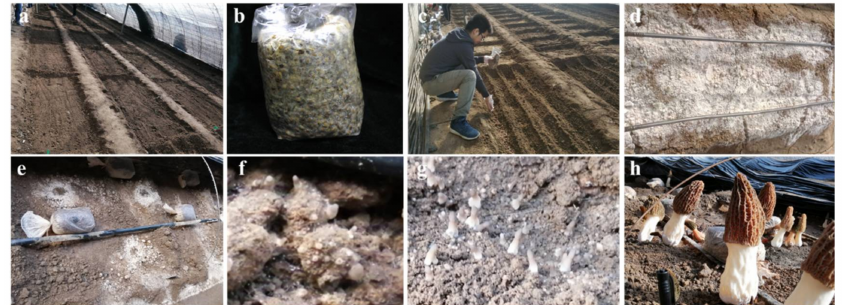
Figure 1. Fruiting body cultivation of morel. ( a ) Prepared soil; ( b ) spawn; ( c ) sowing the spawn; ( d ) conidia (‘powdery mildew’); ( e ) adding exogenous nutrition bags (ENB); ( f ) primordia; ( g ) delin- eating pileus and stipe; and ( h ) mature fruiting body.